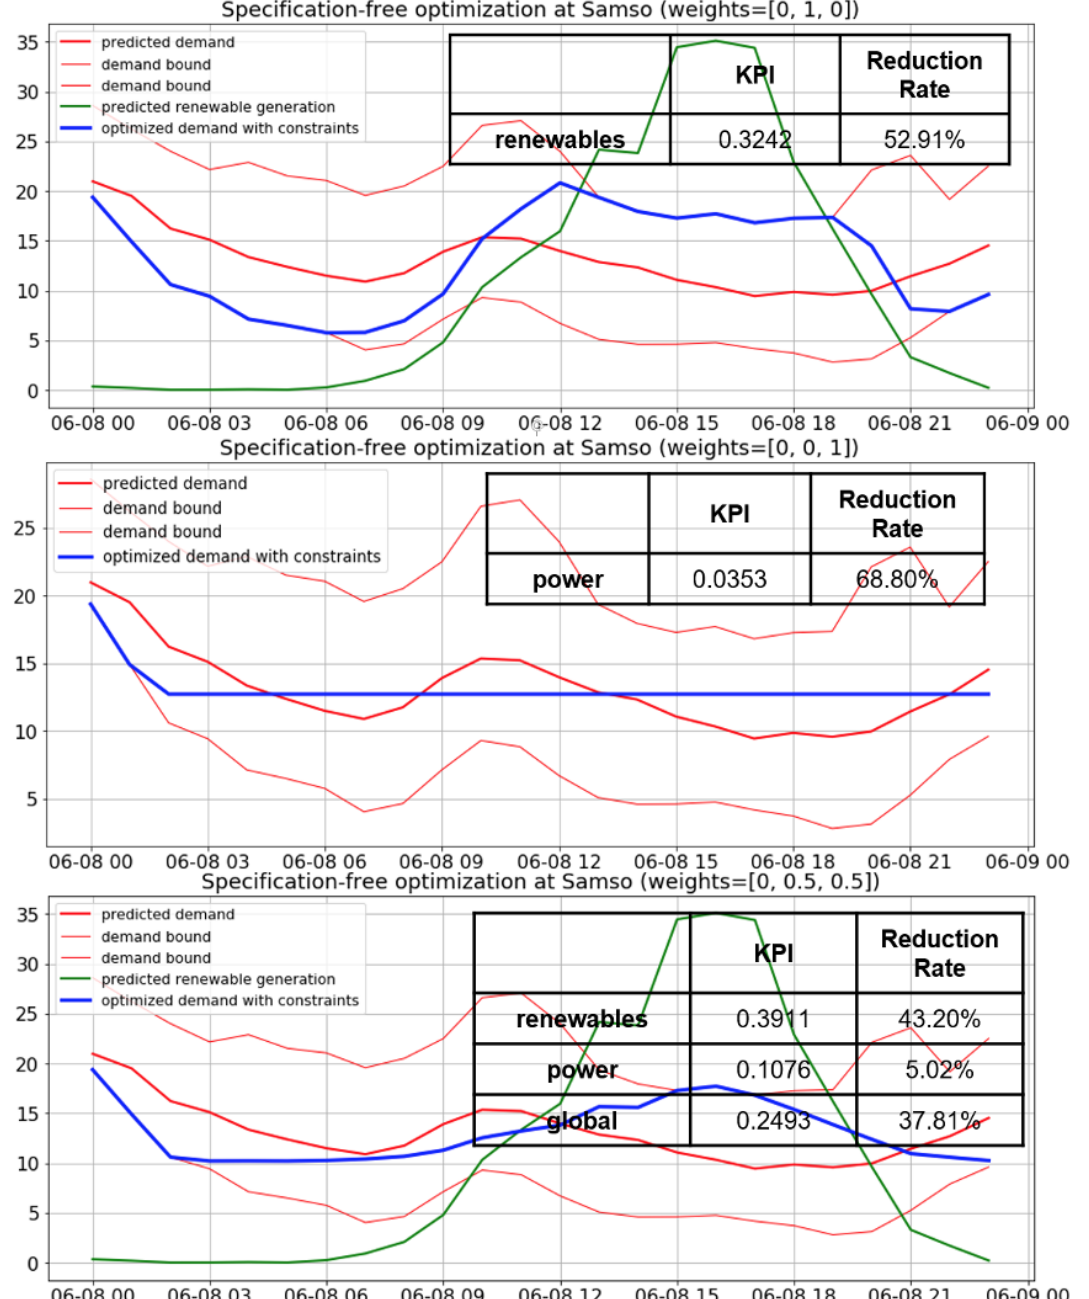
Figure 11. Examples of the application of the optimization approach to Samsø. In the titles, the weights for cost, renewables and power KPIs respectively are shown. In the vertical axis, the measurement unit is